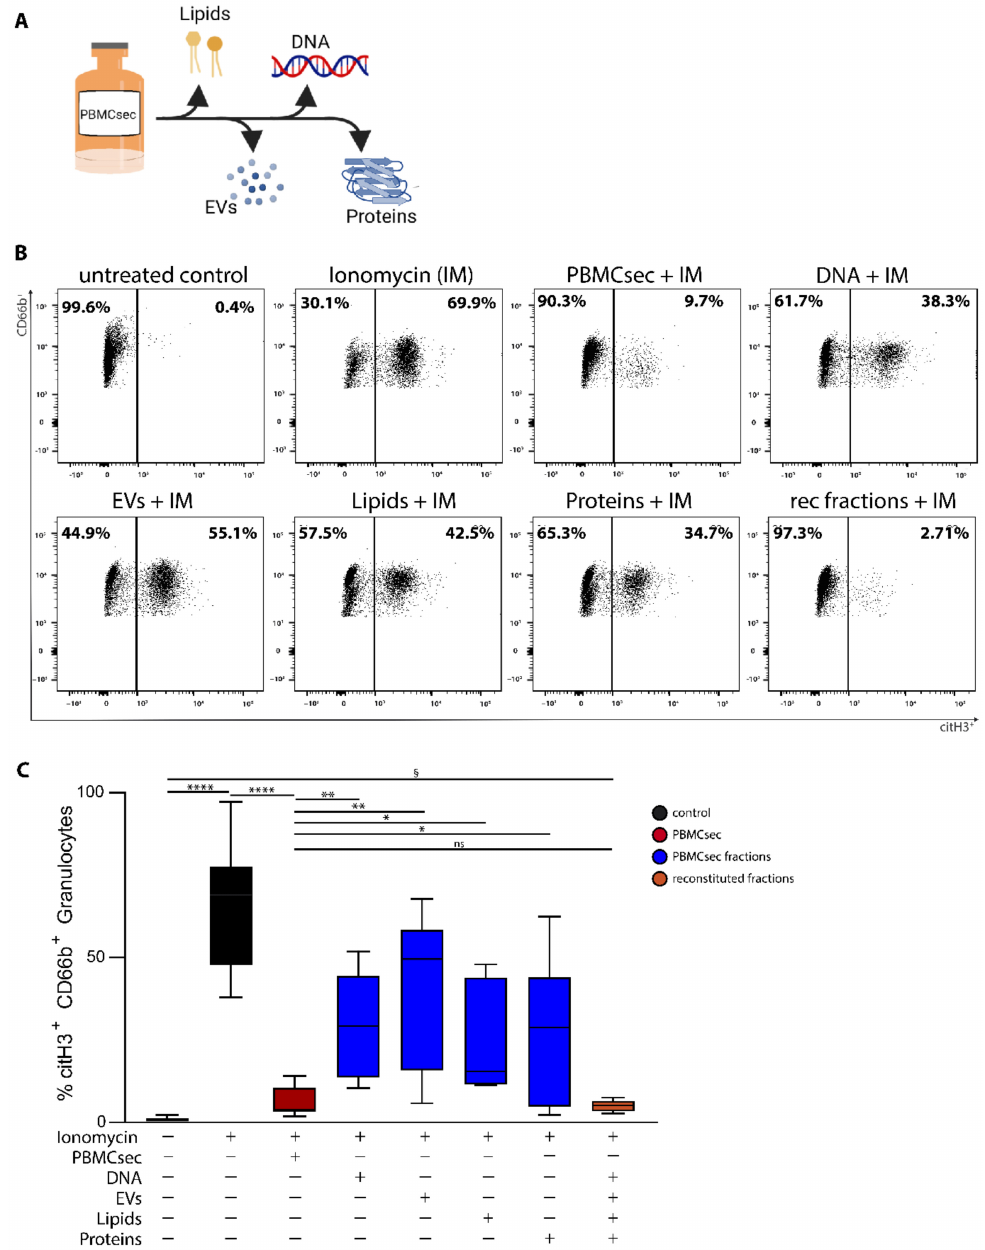
Figure 2. Isolated substance classes of PBMCsec show a synergistic effect on NET-inhibition. ( A ) Schematic depiction of the isolated and tested substance classes of PBMCsec. This scheme